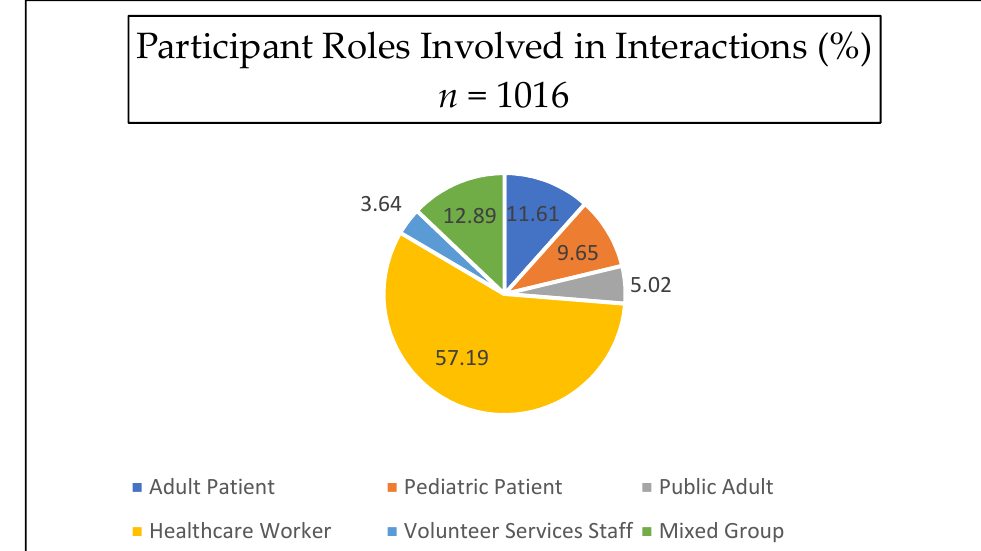
Figure 2. Visit recipient roles as percentages of interactions.